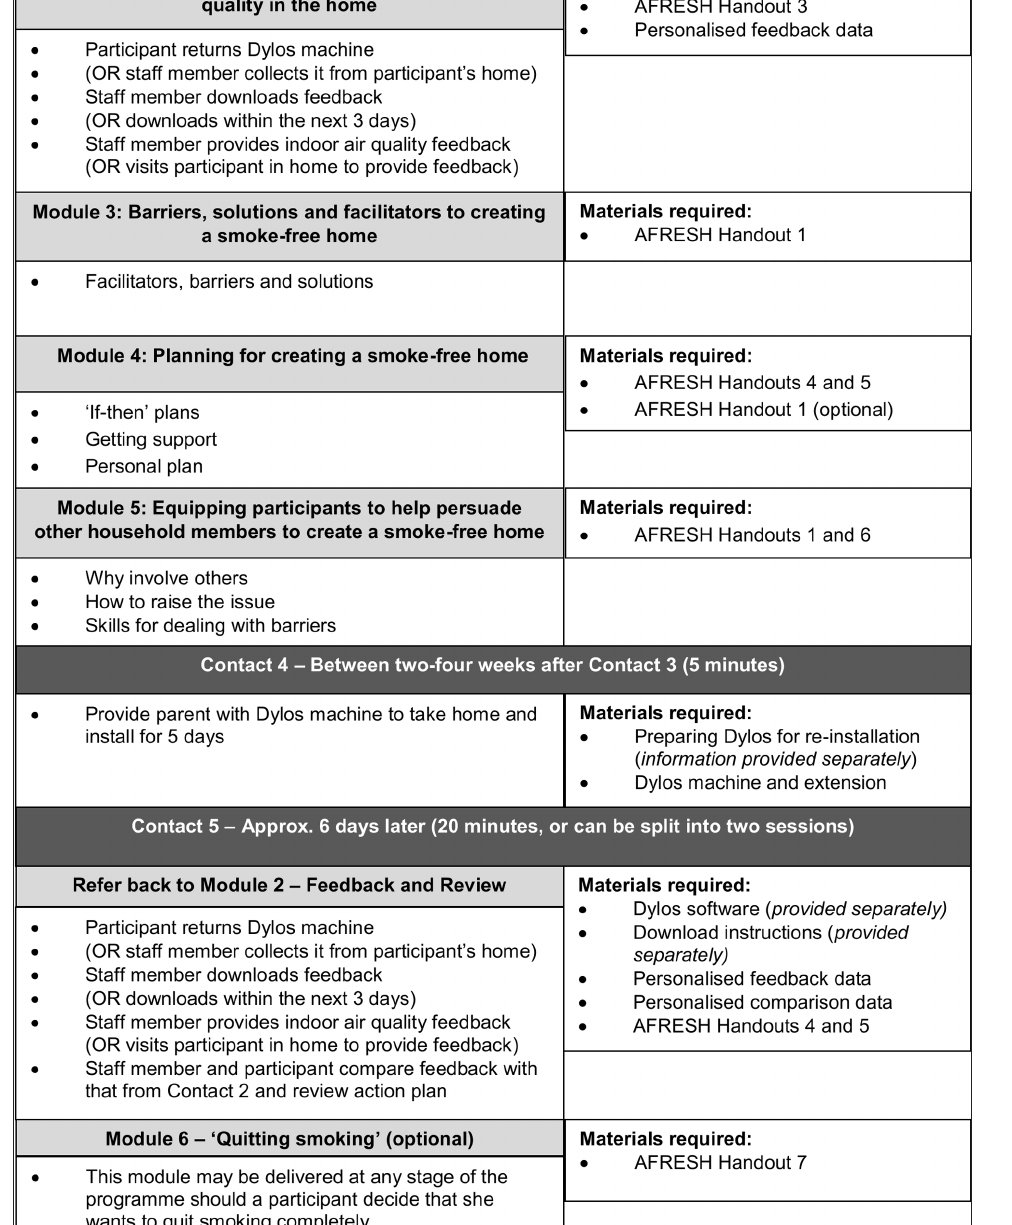
Figure 9: The AFRESH programme